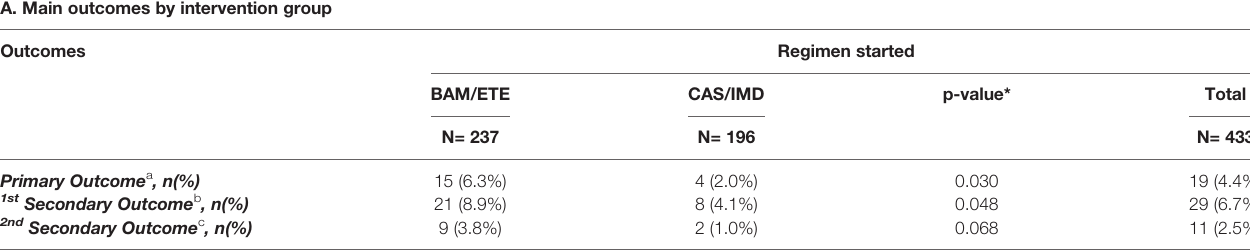
TABLE 2 | Main outcomes by intervention